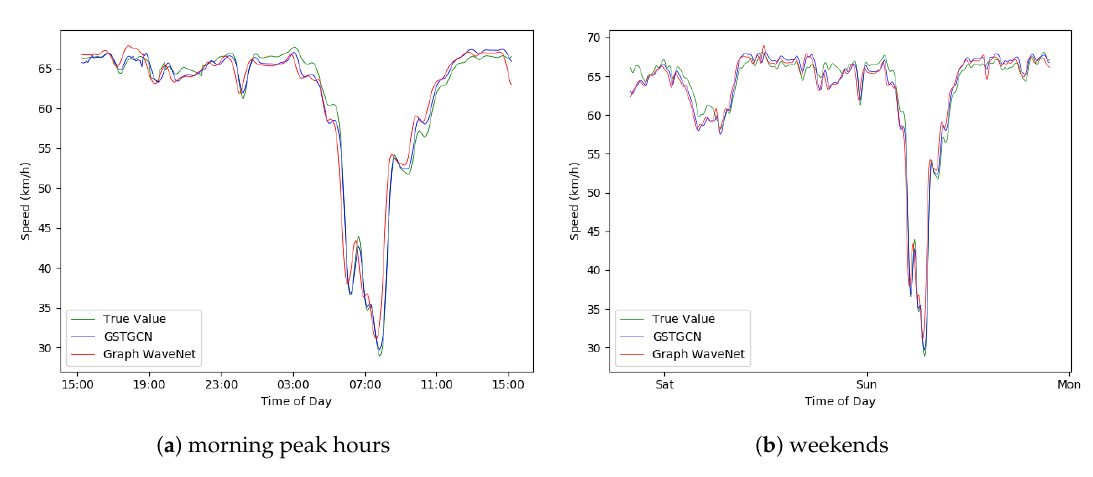
Figure 8. Speed prediction in the morning peak hours and weekends of the dataset PeMSD7. Table 3. Performance comparison of different approaches for traffic prediction on PeMSD7 and PeMSD4 datasets. The best results are marked in